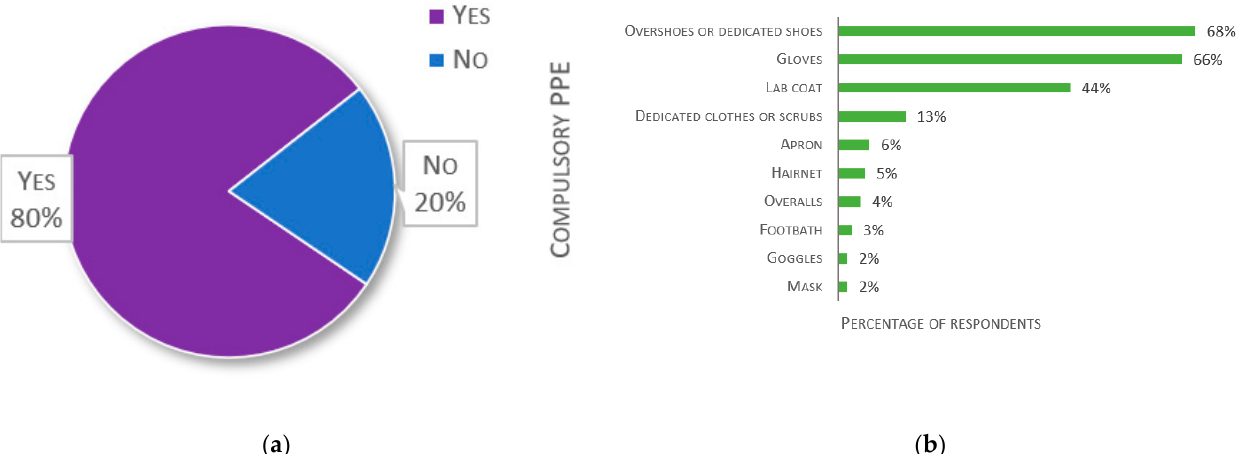
Figure 13. Responses about Personal Protective Equipment (PPE): ( a ) Percentage of respondents having compulsory PPE when entering the aquatic facility ( n = 137); ( b ) Responses to the multiple- choice question: “Which PPE is compulsory when entering your aquatic facility?”, presented as percentage of respondents ( n = 117). Each respondent was allowed to select multiple answers.